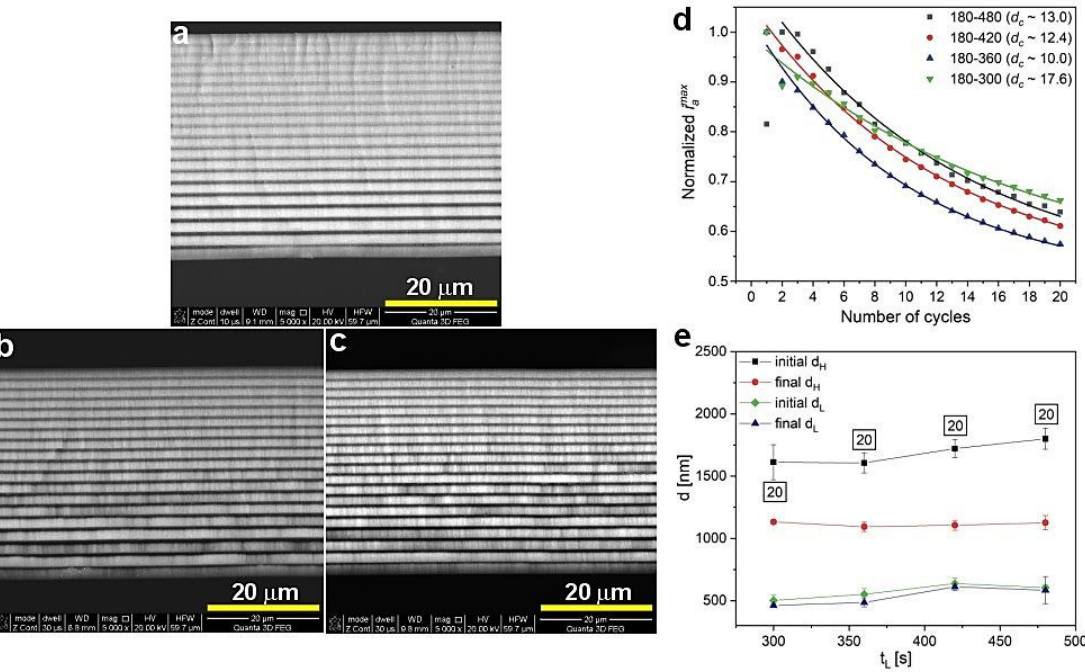
Figure 10. BSE images of the samples PAA_180-420 ( a ), PAA_180-360 ( b ), PAA_180-300 ( c ), normalized i amax as a function of number of cycles ( d ) and initial and final layer d H and d L thickness as a function t L ( e ); in black squares—the number of d H + d L pairs.